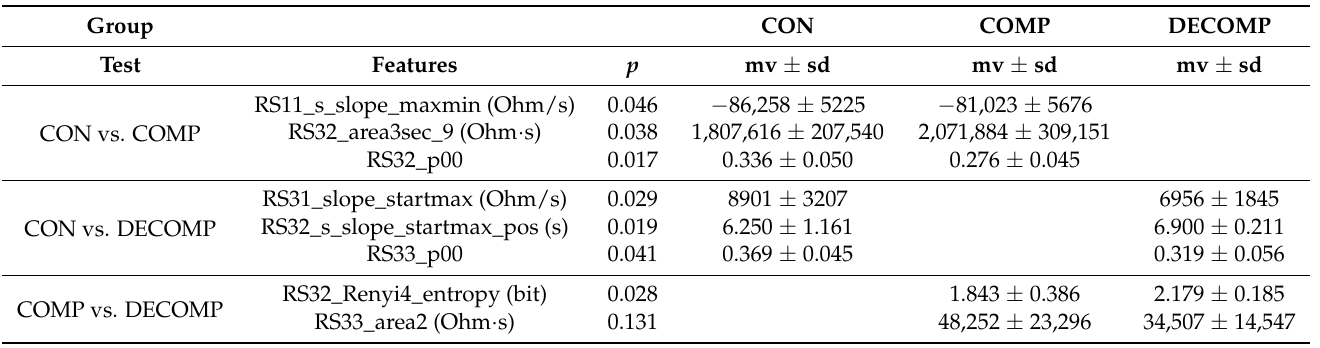
Table 3. Classification results of features automatically selected by discriminant analysis (mv—mean value, sd—standard deviation).